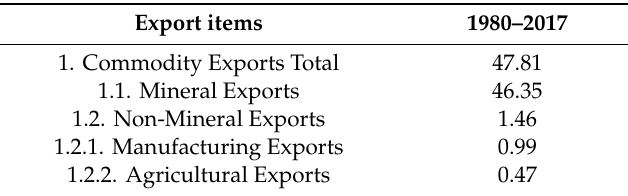
Table 1. Percentage share of mineral, manufacturing, agricultural, and non-mineral exports in GDP, Angola,